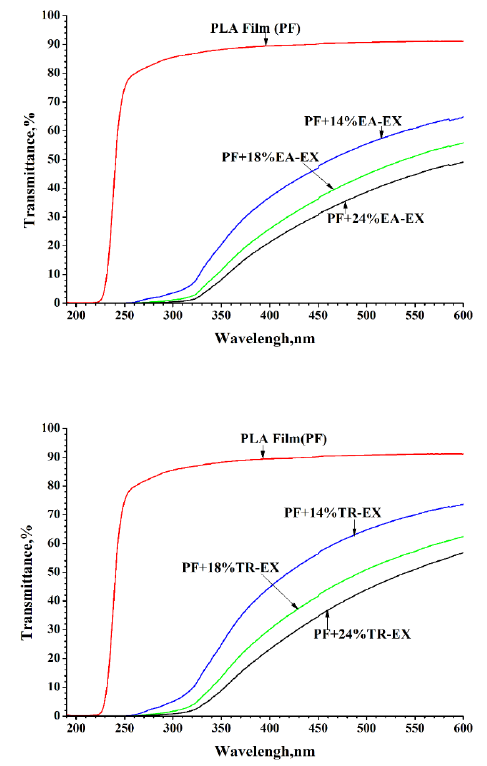
Figure 7. Transmittance spectra of the neat PLA film and the UV-shielding films.